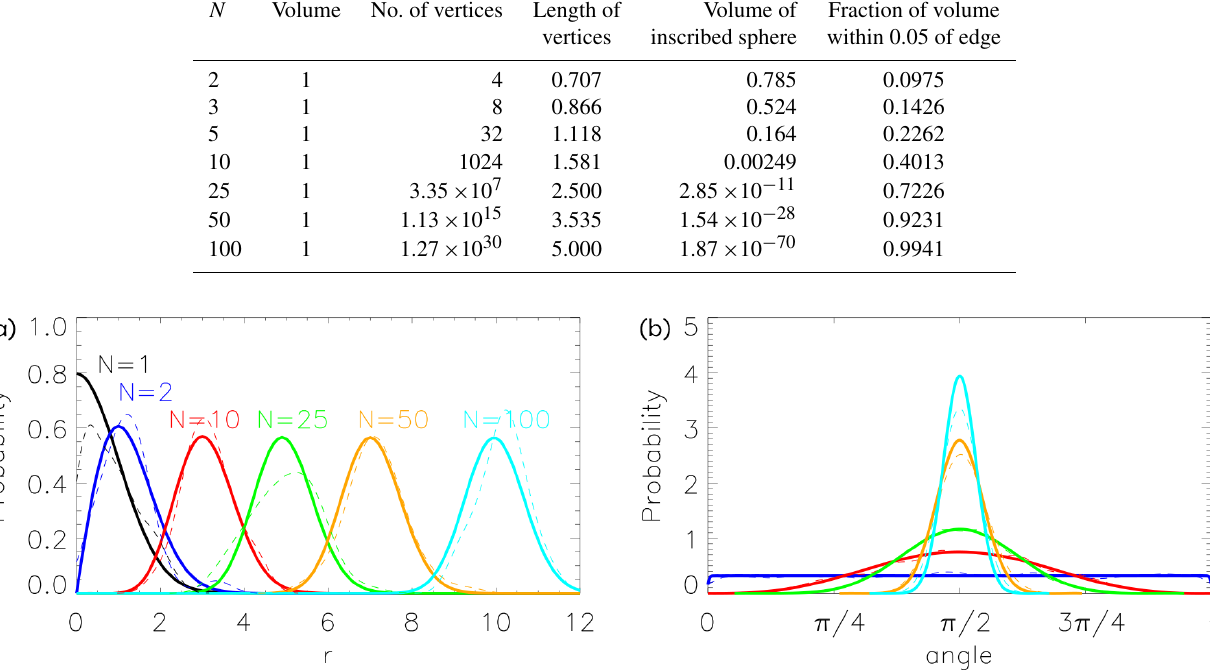
Figure 1. (a) N -dimensional Gaussian distributions with unit variances and zero means as a function of r = || x || for different values of N √ N and the width is approximately the constant 1 / (Eq. 3). The position of the mode goes like pairs of independent N -dimensional Gaussian vectors for the same values of N . Thick curves are calculated in the large ensemble limit. For both (a) and (b) the thin dashed curves illustrate the distributions for a sample of size 50. (cid:113) (cid:112) µ 1 x i )/E( (cid:80) x i ) = Thus, Var ( (cid:80) . Therefore, when i i N σ